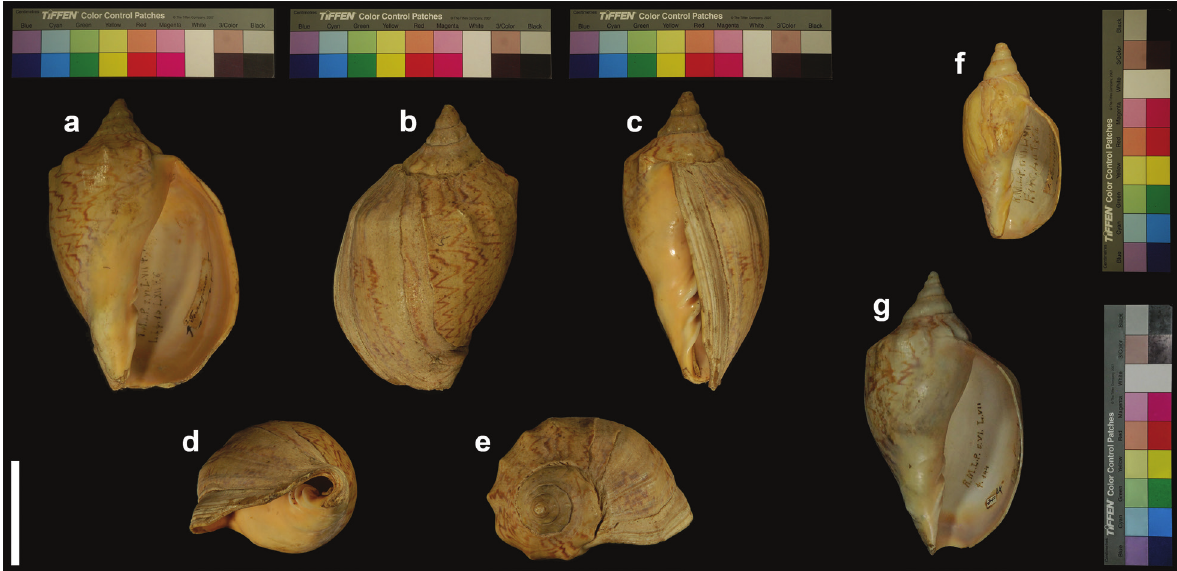
Figure 52. Voluta tuberculata ferruginea . a–e Specimen figured by Lahille (1895: pl. I, fig. 13; pl. VII, fig. 145; pl. XII, fig. 6) a Apertural view b Dorsal view c Lateral view d Umbilical view e Apical view f Specimen figured by Lahille (1895: pl. VII, fig. 146; pl. II, fig. 76a) in apertural view g Specimen figured by Lahille (1895: pl. VII, fig. 144) in apertural view. Scale bar: 5